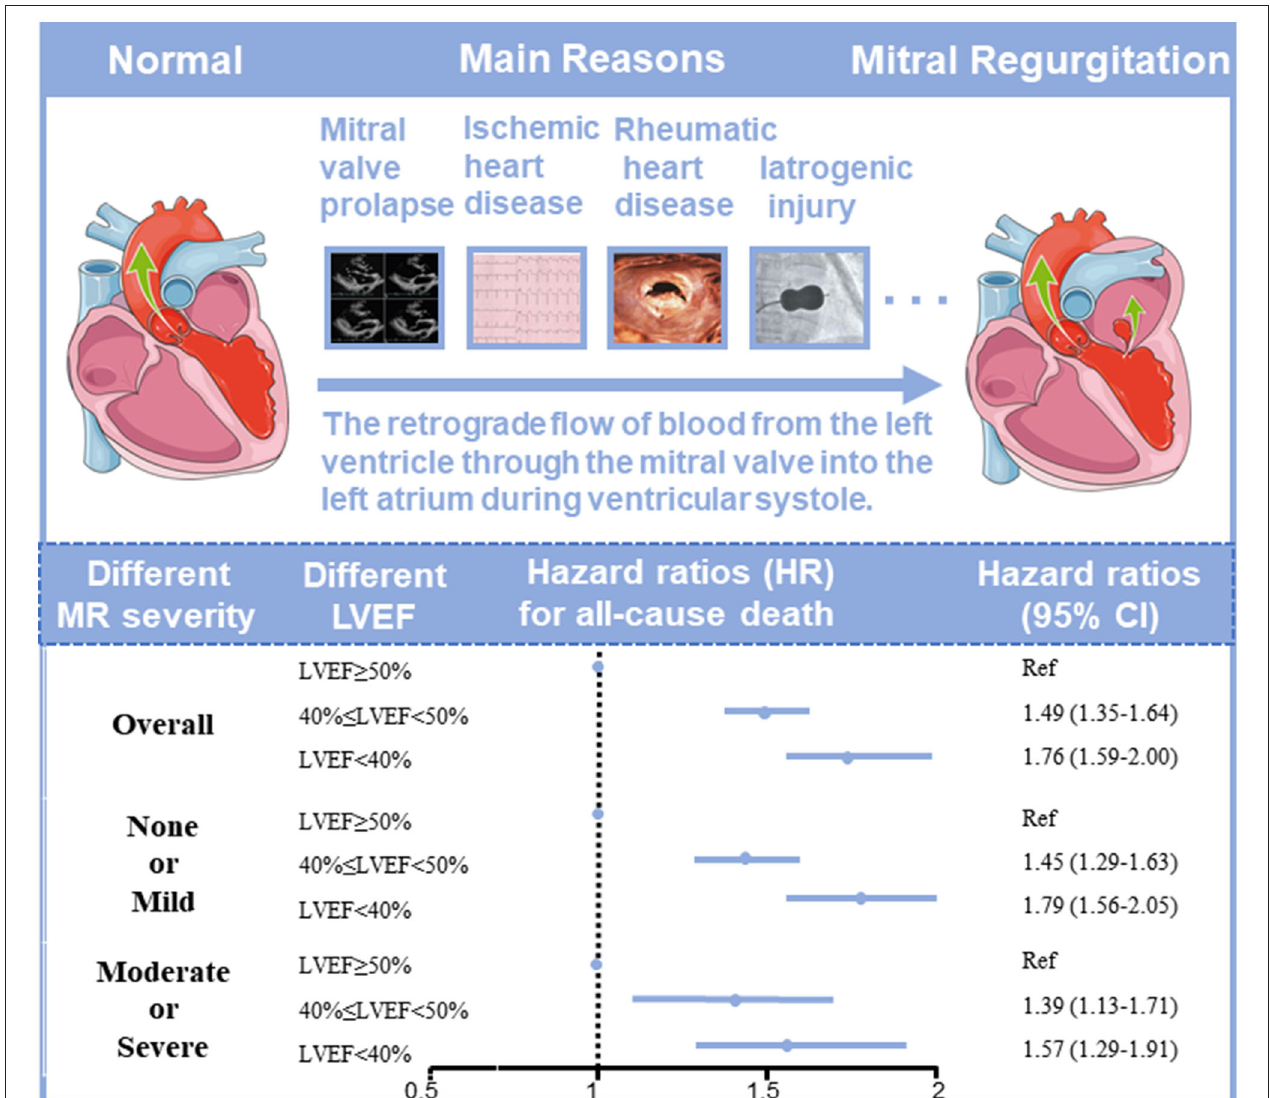
FIGURE 2 | The association between left ventricular ejection fraction (LVEF) and long-term prognosis in coronary artery disease (CAD) patients with different severities of mitral regurgitation (MR).